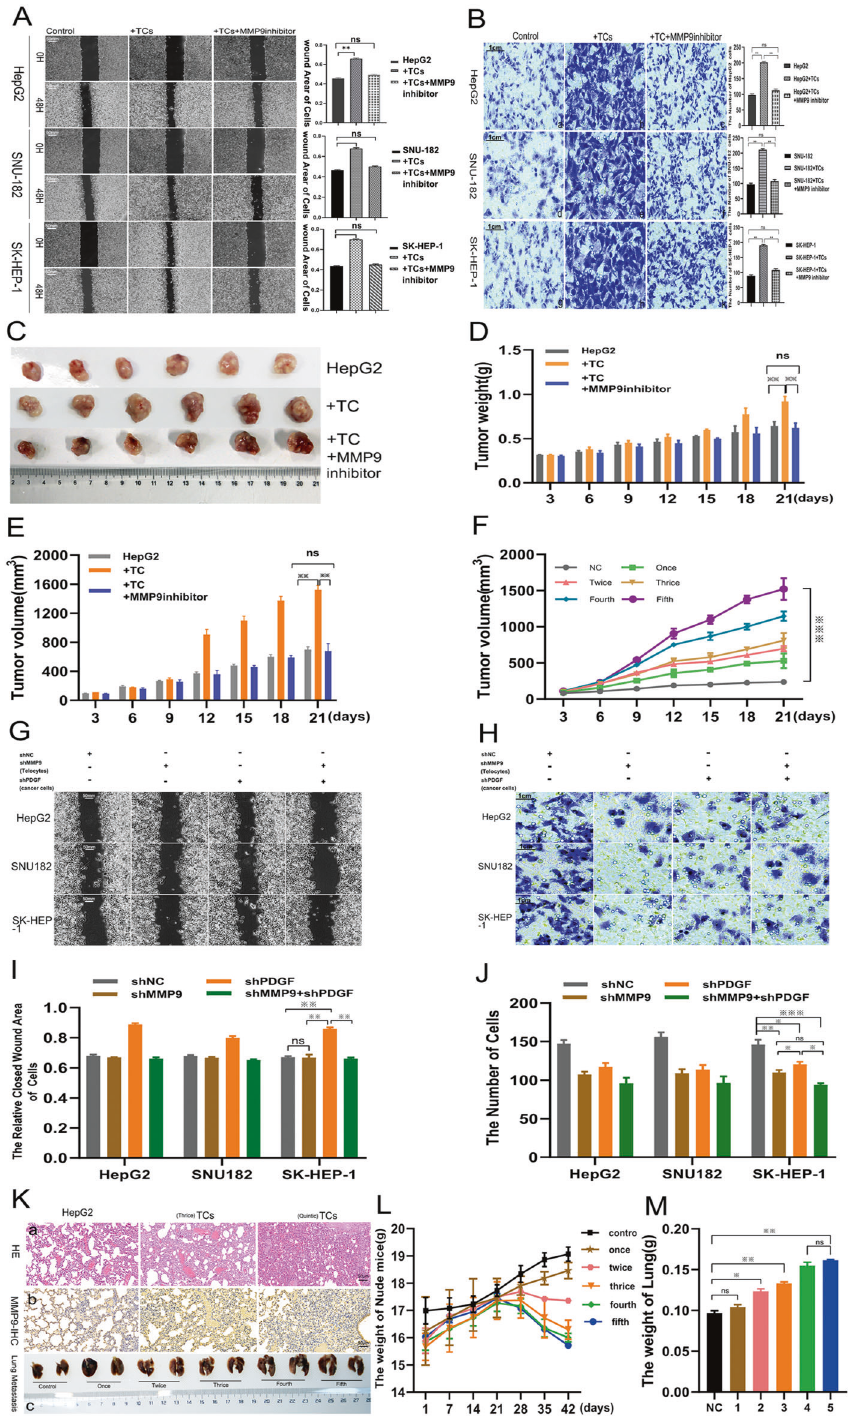
Fig. 4 Telocytes promote cancer cell metastasis depending on MMP9 expression. TCs promoted the migration of hepatic cancer cells as determined by the wound healing assay ( A ) and facilitated the invasion of hepatic cancer cells as determined by the Transwell assay ( B ). Representative photos of xenograft tumors in vivo, ( C ) growth curves of tumor weight ( D ) and volume ( E ) over time in the HepG2, TCs, and TCs + MMP9 inhibitor groups. Growth curves of tumor volume with incremental TC injections ( F ). Knockdown of MMP9 and PDGF- α in TCs and HCC, respectively, in fl uenced the migration and invasion of hepatic cancer cells after 48 h as determined by the wound healing and Transwell assays ( G , H ). The number of migrating cells ( I ) and invasive cells ( J ) in the shMMP9 and shPDGF- α groups were determined. Representative photographs of metastatic lung tissues derived from HepG2 cancer cells at different frequencies of TCs injection as determined by hematoxylin and eosin staining ( K -a) and in vivo ( K -c). MMP9 expression as determined by immunohistochemistry staining in the different groups ( K -b). Contrast curves of the weights of nude mice ( L ) and the weights of metastatic lung tissues ( M ) at different frequencies of TC injection. ns: no signi fi cance; * p < 0.05, ** p < 0.01, *** p <